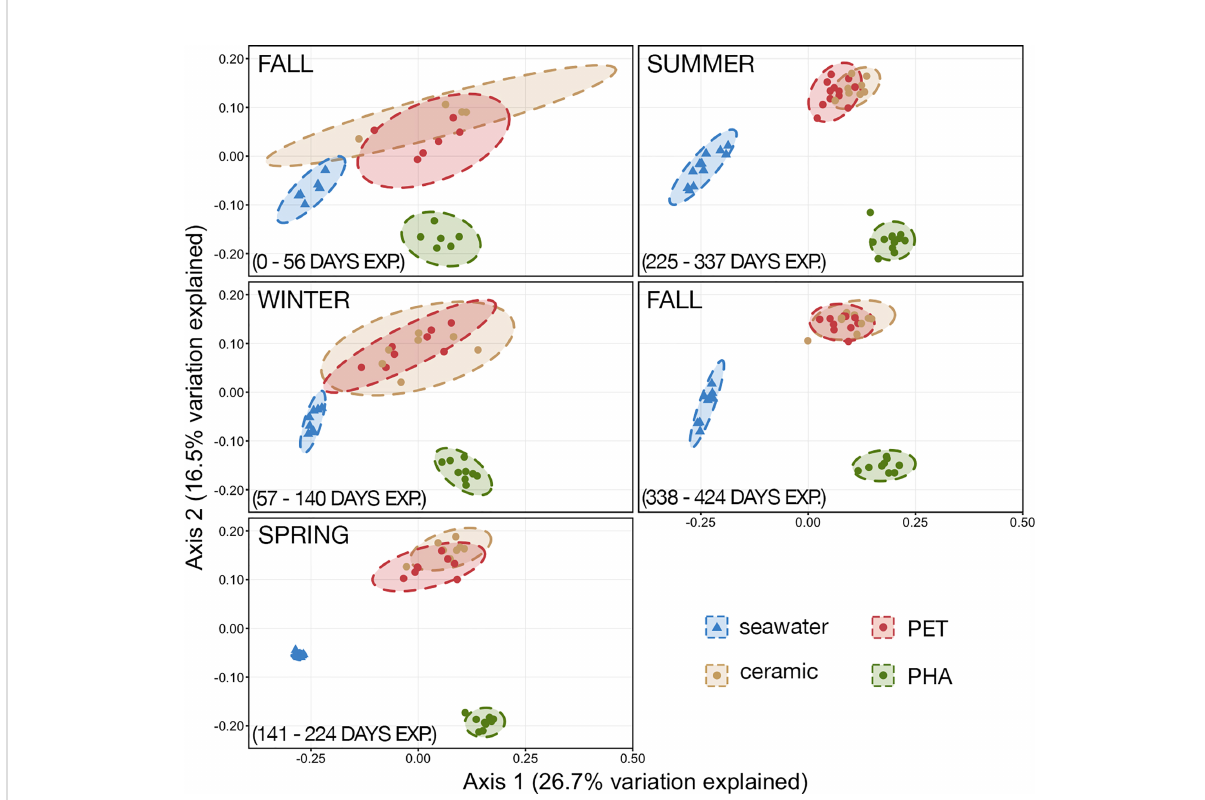
FIGURE 3 Principal coordinates analysis (PCoA) of generalized Unifrac distances illustrating the variation in microbial community structure. The PCoA demonstrates the clustering of 16S rRNA gene sequences from seawater (n=45), ceramic (n=40), PET (n=40), and PHA (n=45). Dashed lines represent the 95% con fi dence ellipses for each community type.